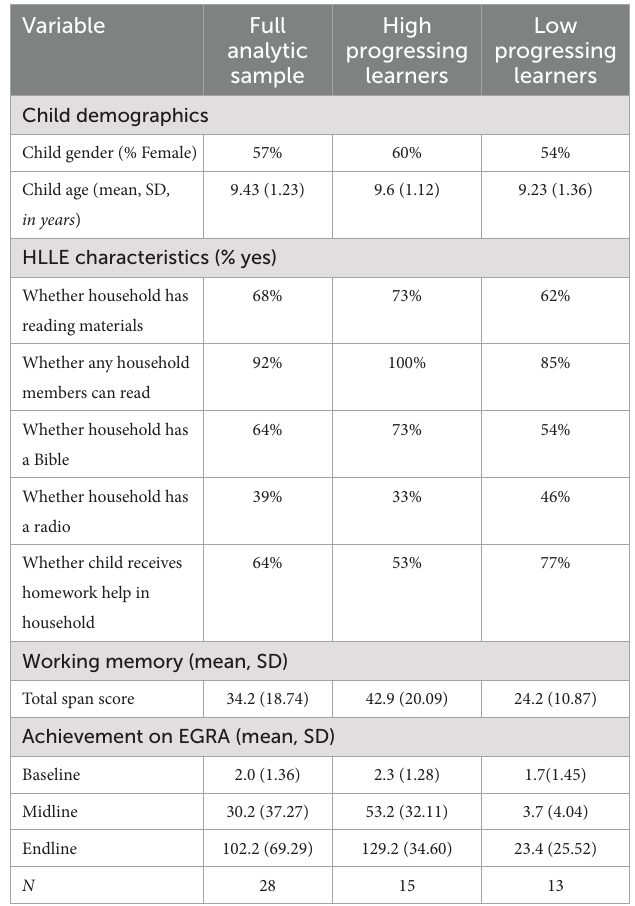
TABLE 1 Descriptive statistics for analytic